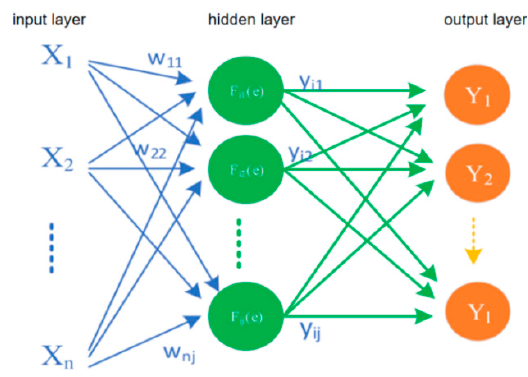
Figure 9. Schematic diagram of back propagation neural network. Each hidden layer contains multiple neurons. The neuron format is shown in Figure 10. The number of input X and output Y is set as required, but X 0 is the specified value − 1. Each input corresponds to a weight win, and X 0 corresponds to w 0 θ . In the calculation process, the sum is first and then the mapping is performed.